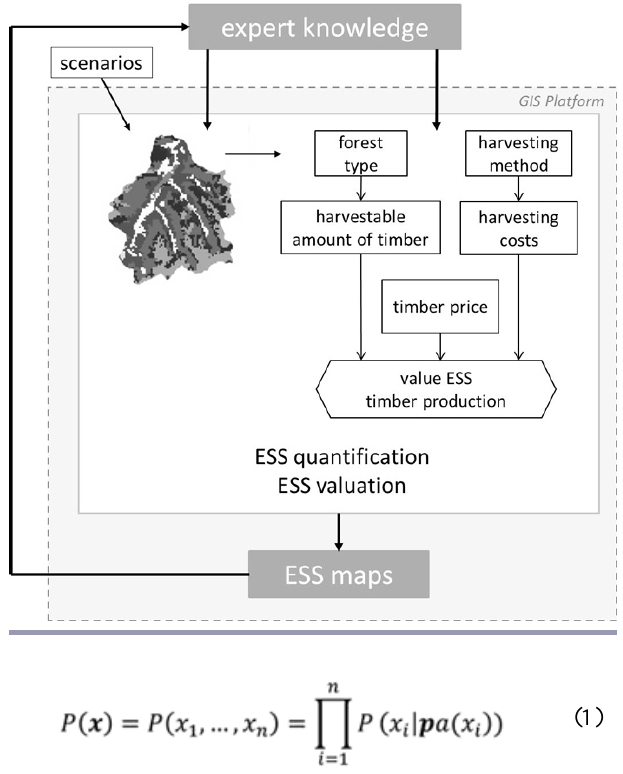
Fig. 2 . Illustration of the iterative integration of expert knowledge into the mapping of ecosystem services